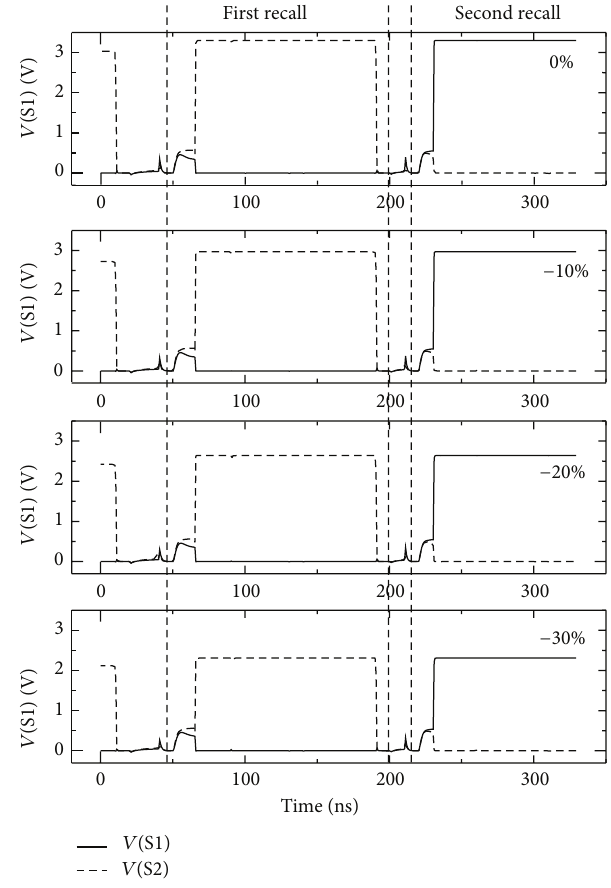
Figure 12: Effect of fluctuations on power supply voltage. Power supply voltage varied from − 30% to 0%.